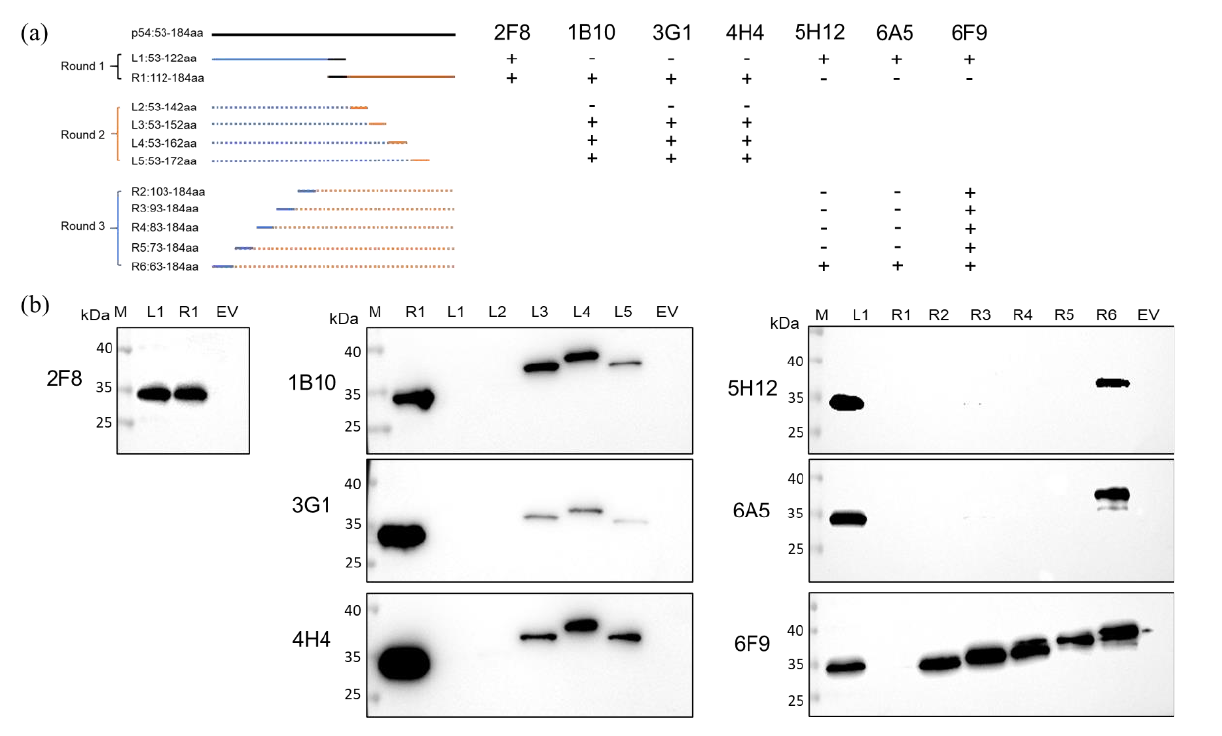
Figure 4. Antigen epitope analysis. ( a ). Strategy for the identification of the epitopes within rp54